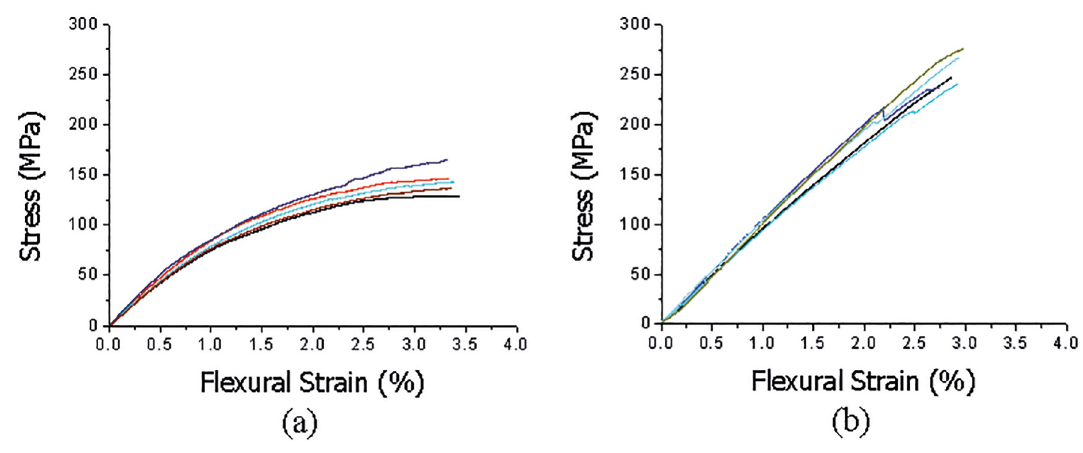
Figure 5. Stress x Flexural Strain (three - point bending): (a) HSCL; (b) HFCL.